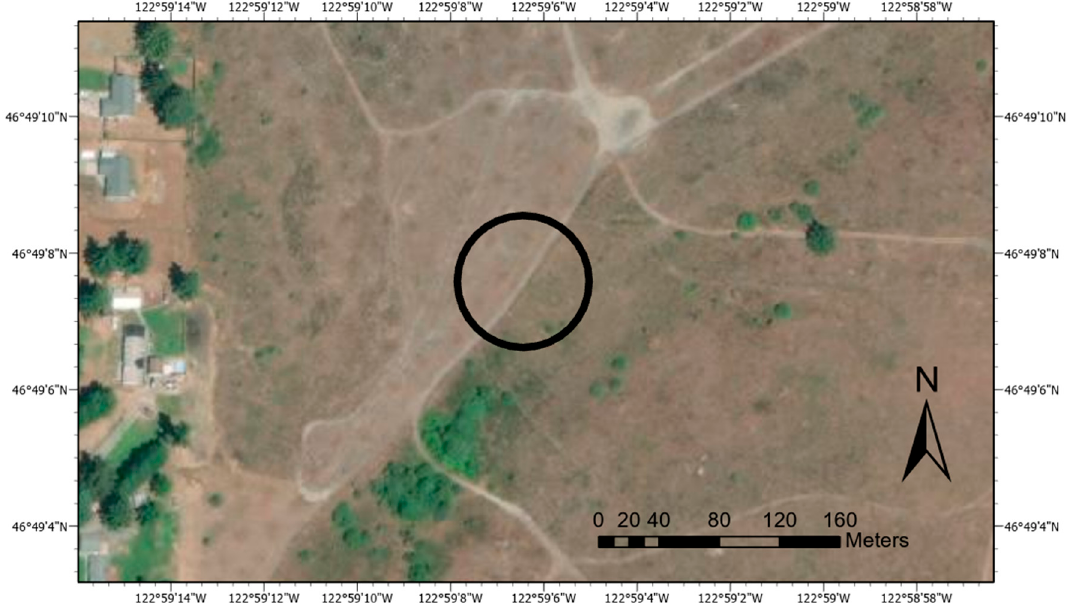
Figure 1. Overhead Image of Study Site in Context, with the Study Area Circled.